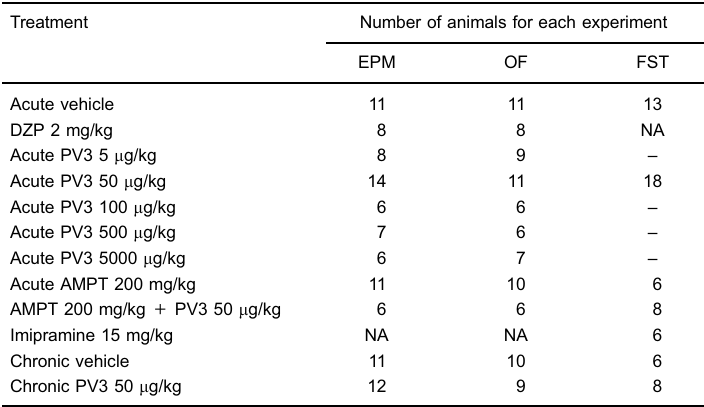
Table 1. Treatments used to assess the effects of Phaseolus vulgaris peptide (PV3) on different behaviors. Treatment Number of animals for each experiment EPM